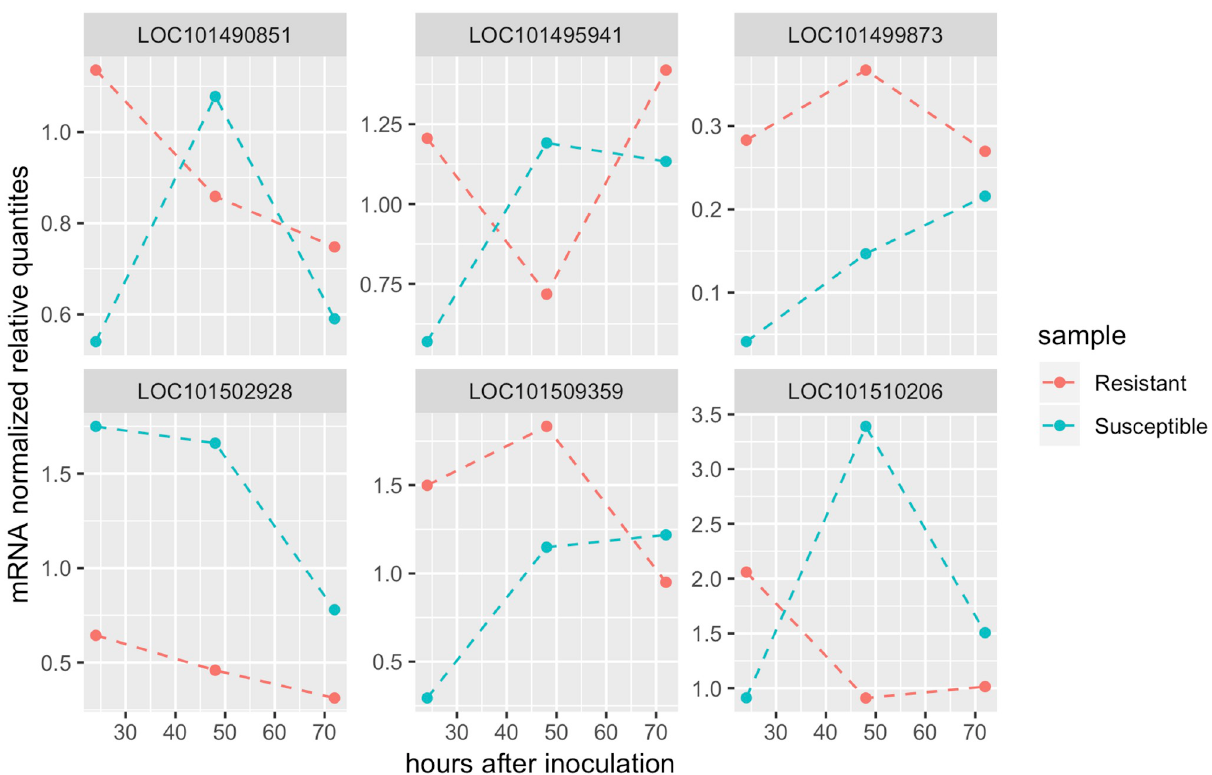
Fig 3. Expression profile of candidate genes in roots of chickpea over the time-course experiment. Red line shows the averaged expression level in resistant NILs, whereas blue line describes the averaged level in the susceptible NILs.